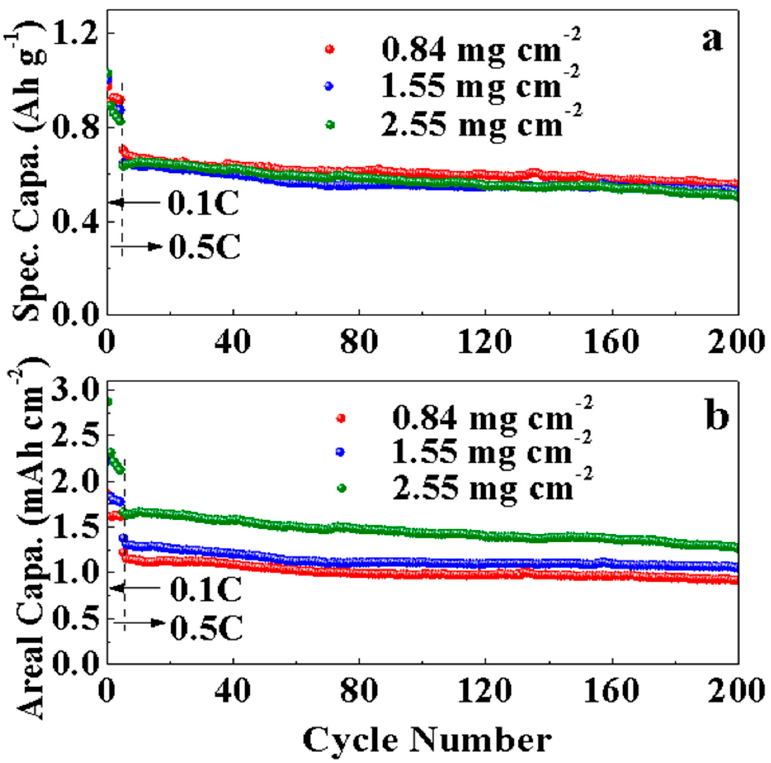
Figure 10. ( a ) Specific capacities and ( b ) areal capacities of the MPC-8S cell with different mass load-